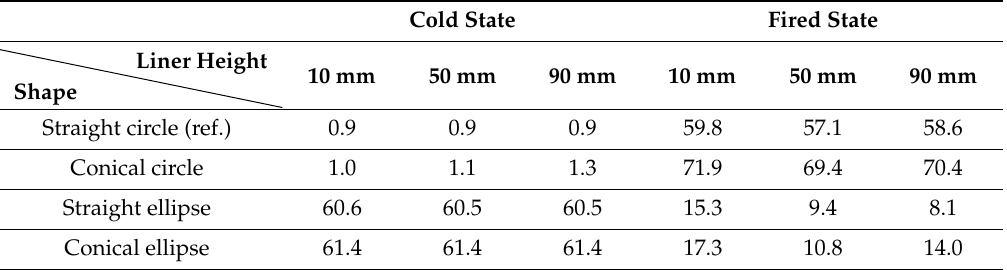
Table 4. Roundness deviation for the liner in both the cold state and under typical fired operational conditions at di ff erent heights within the liner. (Numbers are given in micrometers). Cold State Fired State